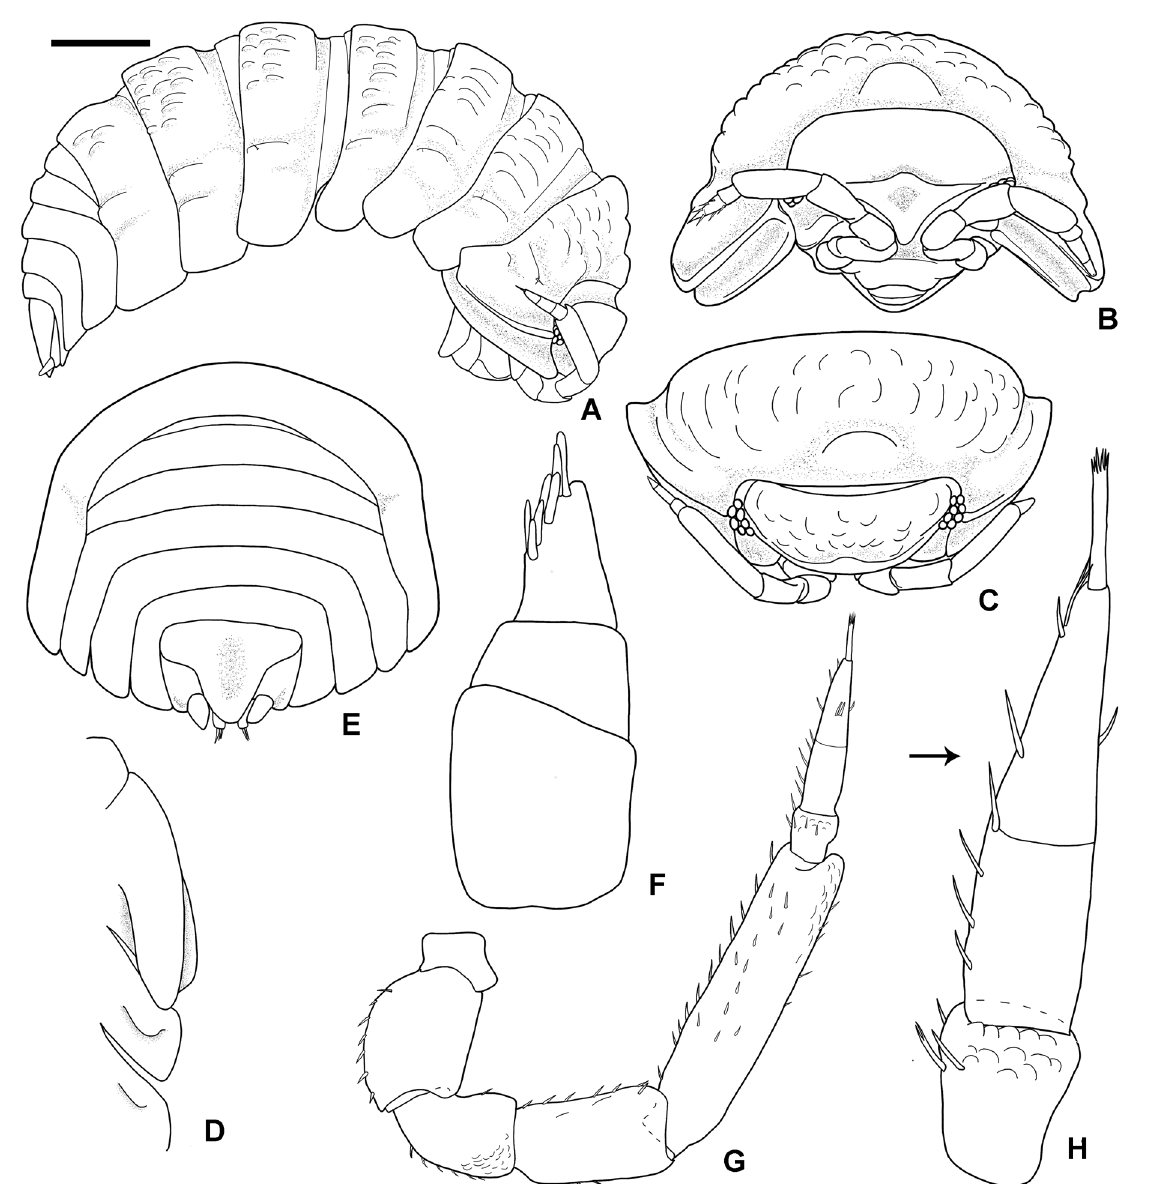
Fig. 3. Brasiloniscus verrucosus (Lemos de Castro, 1973) gen. et comb. nov. , paratype, ♀ (MNRJ 6214). A . Habitus, lateral view. B . Cephalon and pereonite 1, frontal view. C . Cephalon and pereonite 1, dorsal view. D . Pereonites 1–3, ventral view. E . Pereopod 7, pleon, telson and uropods, dorsal view. F . Antennula. G . Antenna. H . Antennal flagellum. Scale bar: 1